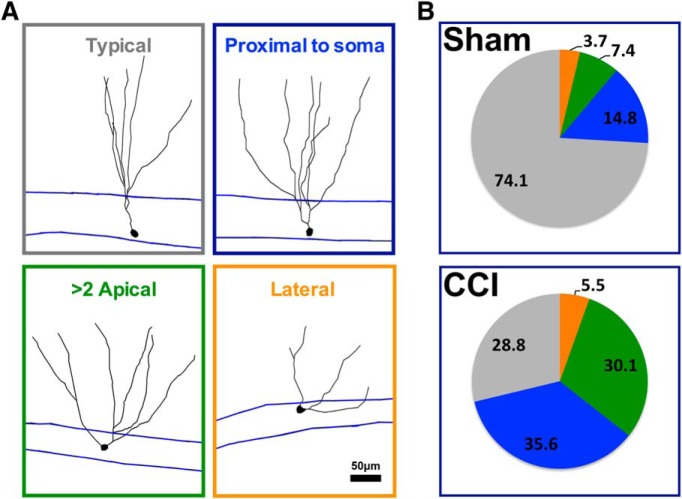
CCI increased the heterogeneity of dendritic branch morphology in cells born after injury. A, Representative morphology of tdTom+ cells categorized according to their dendritic phenotype. B, The majority of tdTom+ cells in sham mice were characterized by a single apical dendrite that branched farther away from the cell body (>10 μm from soma, typical cell), whereas the majority of tdTom+ cells in CCI-treated mice branched more proximal to their somata (<10 μm), had more than one apical dendrite, or had an apical dendrite that projected laterally from their soma (<30° from GCL). There were fewer typical tdTom+ cells in CCI-treated mice compared with sham mice (p = 0.02138, n = 5 mice/group).